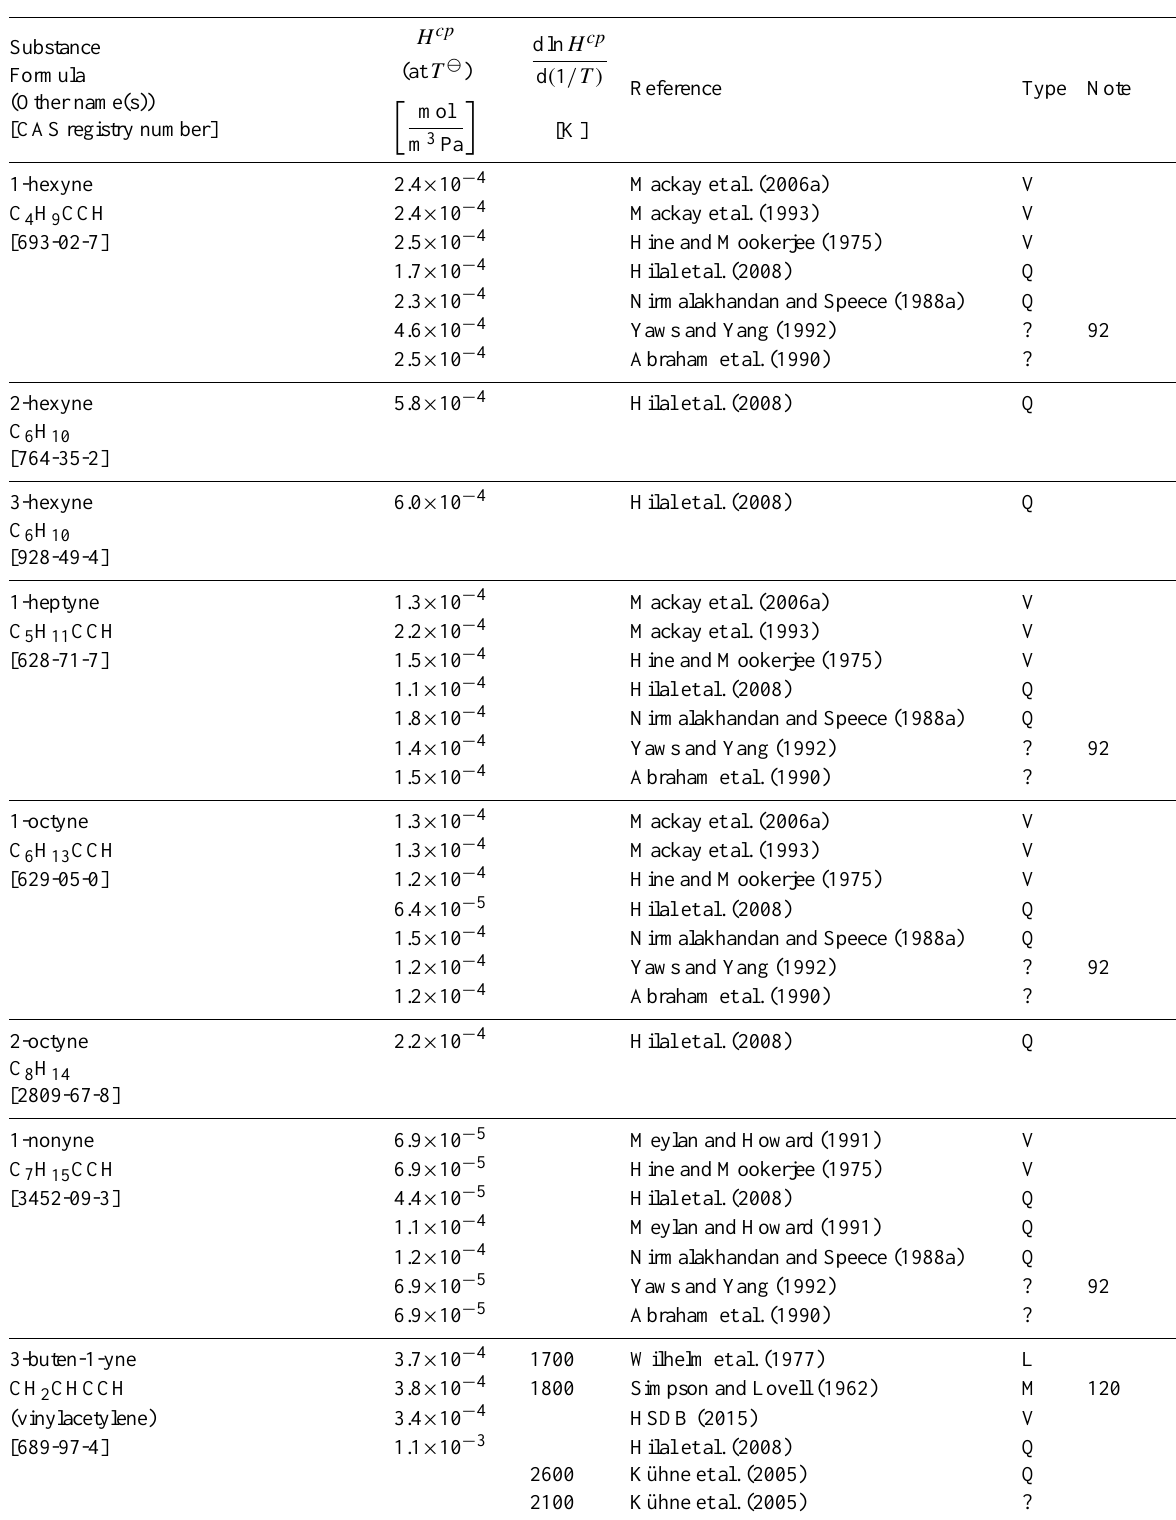
Table 6: Henry’s law constants for water as solvent